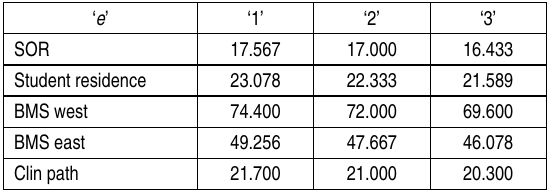
Table 2b. Observed and expected laboratory capacity for SOR